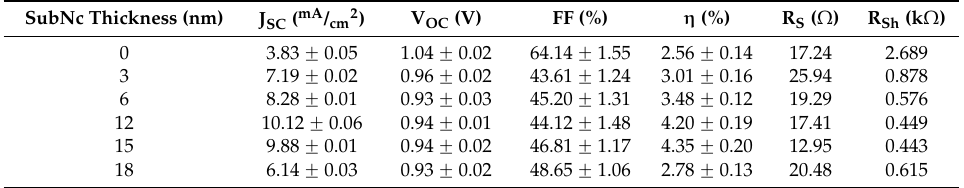
Table 4. The photovoltaic performance of three-layer OSCs ( α -6T/SubNc/SubPc) is sorted and estimated the properties of devices with MoO 3 (10 nm), SubPc (18 nm), BCP (10 nm), and Ag (100